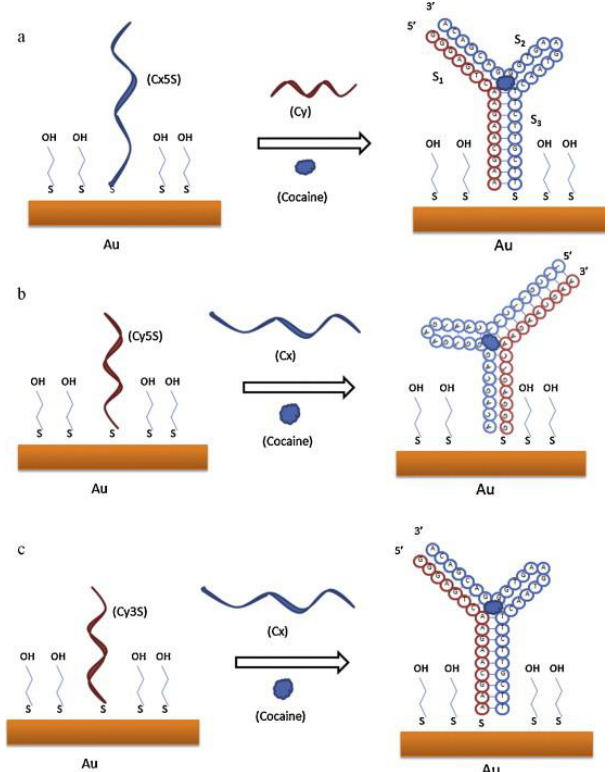
Figure 8. Aptasensor systems designing with fragments on Au surface with MCE as ( a ) Au/Cx5S/MCE, ( b ) Au/Cy5S/MCE, ( c ) Au/Cy3S/MCE. Reproduced with the permission of [183]. Copyright 2012 Published by Elsevier B.V.